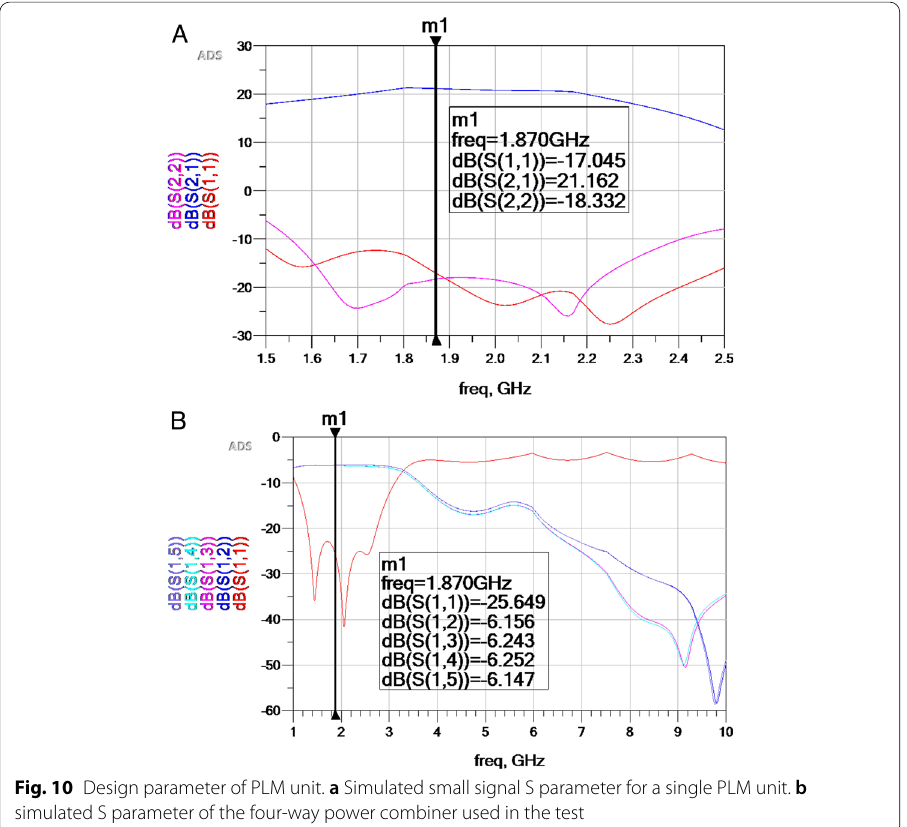
Fig. 10 Design parameter of PLM unit. a Simulated small signal S parameter for a single PLM unit. b simulated S parameter of the four-way power combiner used in the test